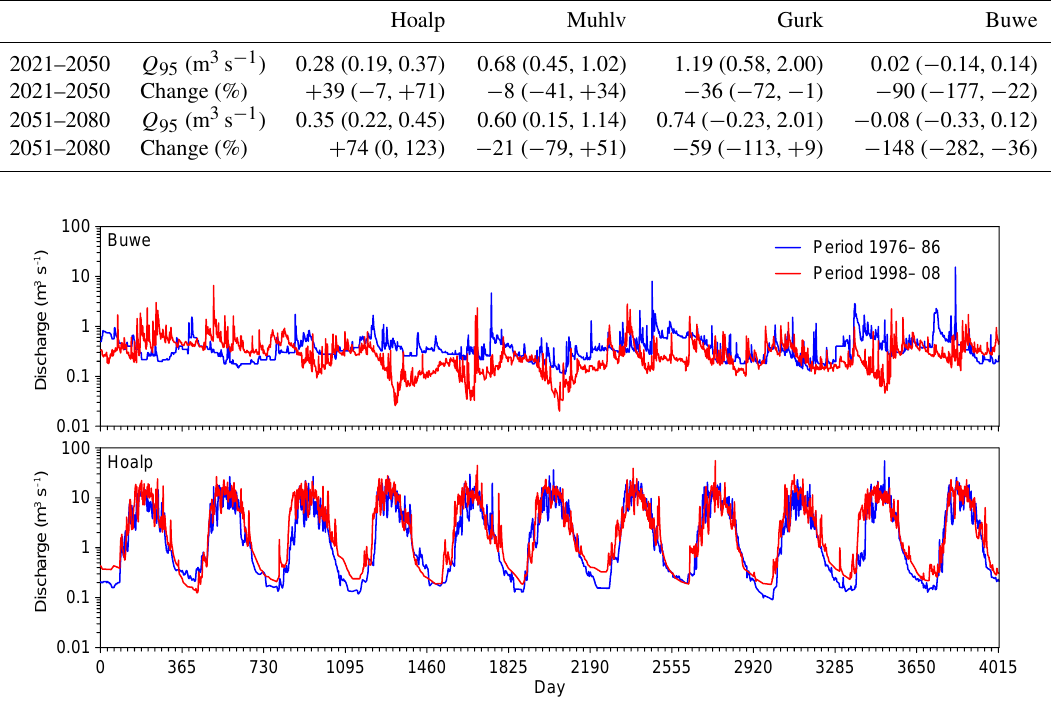
Figure 3. Observed daily discharge for the periods 1976–1986 (blue lines) and 1998–2008 (red lines) in the Buwe (top) and Hoalp (bottom) catchments.